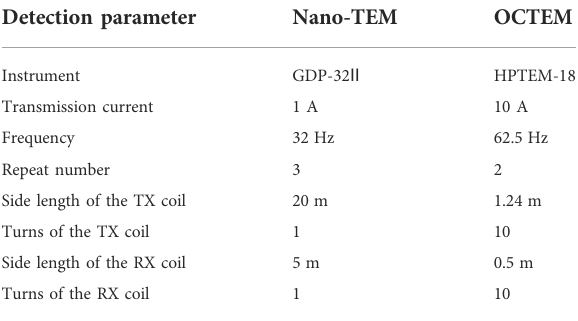
TABLE 1 Detection parameters used in the nano-TEM and